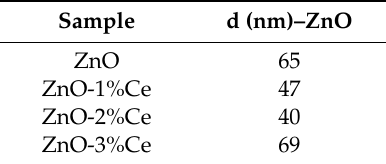
Table 1. The dependence of the crystallite size on the Ce